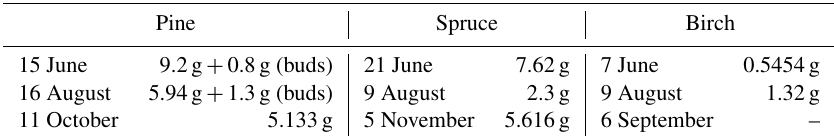
Table B1. Dry weight of the needles’ or leaves’ biomass on the dates the branches were